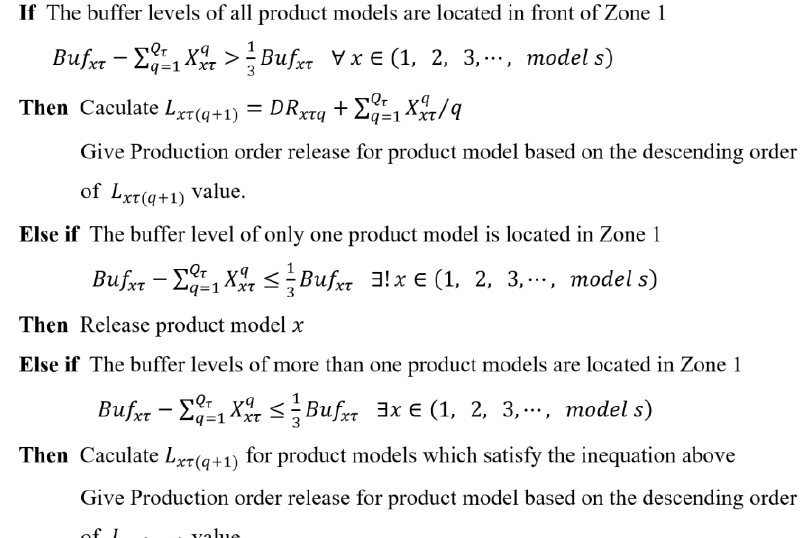
Figure 3. Order release mechanism based on DBR.